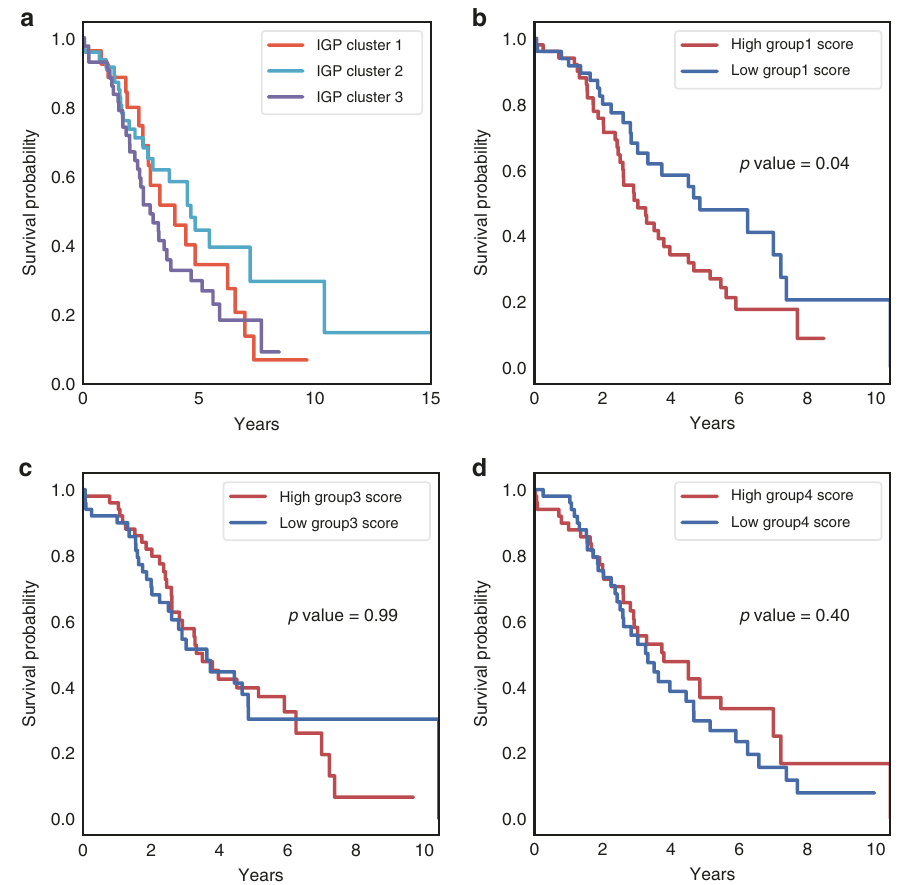
Fig. 3 Kaplan – Meier plot of overall survival strati fi ed by IGP clusters or IGP group signatures. a Three clusters. In IGP cluster 1, n = 27 samples; in IGP cluster 2, n = 49 samples; in IGP cluster 3, n = 43 samples. b Group 1 signature. c Group 3 signature. d Group 4 signature. In b – d , for both groups with highest scores and lowest scores, n = 50 samples. Logrank_test without adjustment is used in b – d